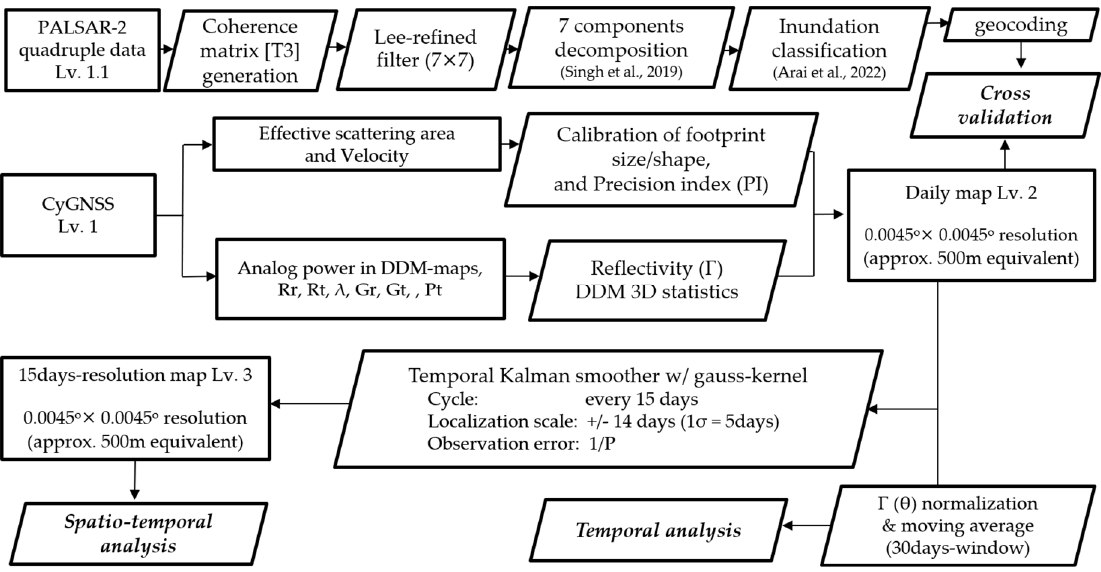
Figure 1. Flowchart of the methodology of this study outlining the data, processing and analysis steps.